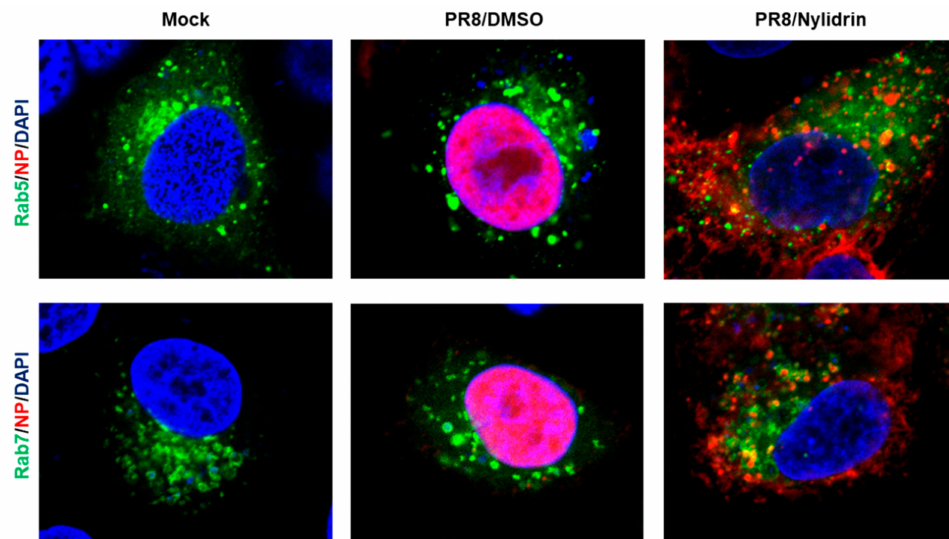
Figure 3. Colocalization of vRNP with endosomal makers, Rab5 and Rab7. A549 cells were transfected with pEGFP-Rab5 or -Rab7 expression plasmid. On the next day, PR8 virus mixed with DMSO or nylidrin (100 µ M) were infected into A549 cells at an MOI of 10 at 4 ◦ C for 30 min. After additional 4 h-incubation at 37 ◦ C, cells were fixed and permeabilized for probing anti-NP antibody and Alexa 633-conjugated secondary antibody. Mock, no PR8 infection. Green, an EGFP-tagged endosomal marker, Rab5 (upper) or Rab7 (lower). Red, viral NP. Blue, cellular nuclei stained with DAPI. Original magnification, 630 ×